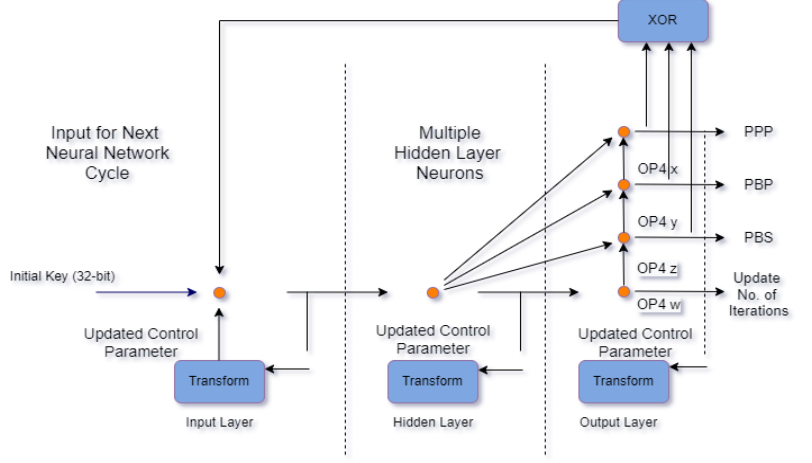
Figure 2. Neural network-based generator